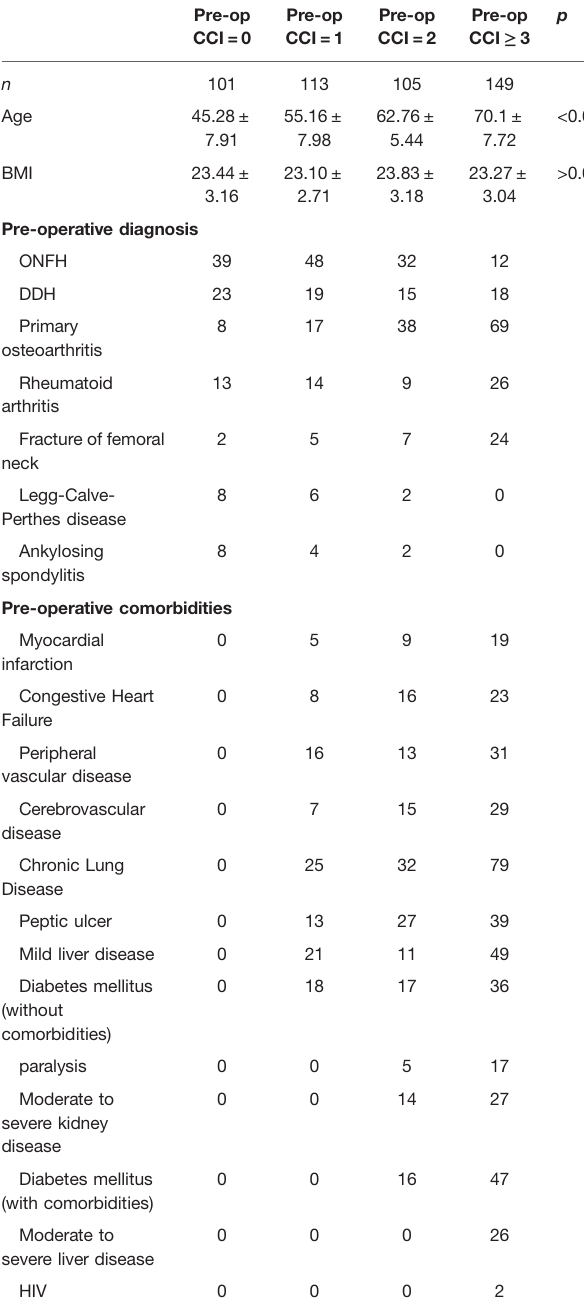
TABLE 3 | Clinical characteristics of different groups of preoperative